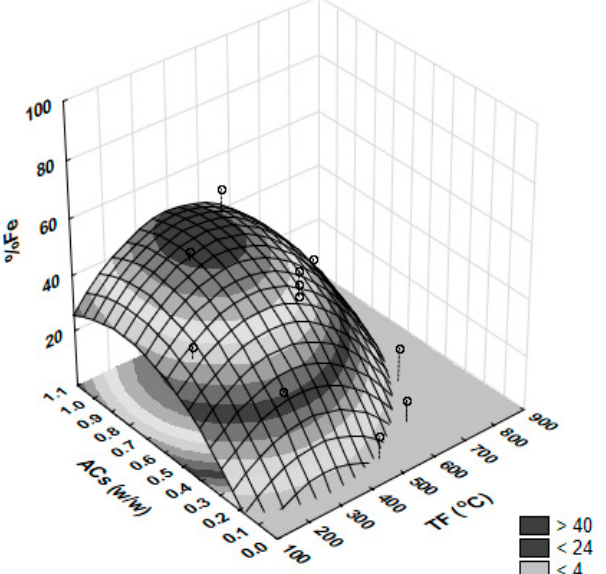
Figure 15. Response surface plot and contour lines for %Fe (Fe extraction) versus TF (roasting temperature) and ACs (Acid/sample mass ratio)—Equation (12) (leaching time—tL = 20 min).